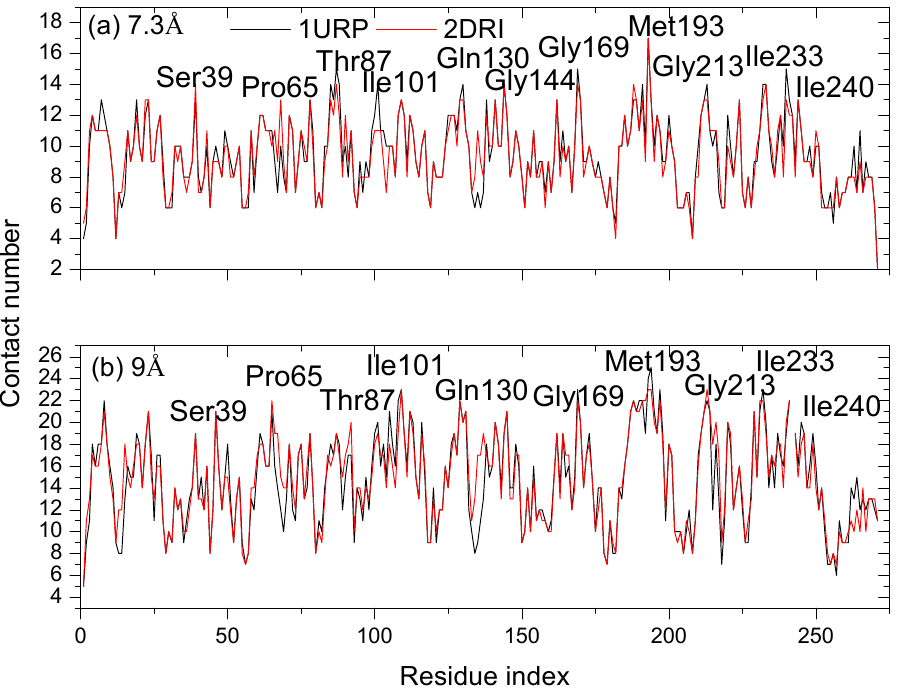
Figure 9. The contact number of all residues in the 1URP and 2DRI